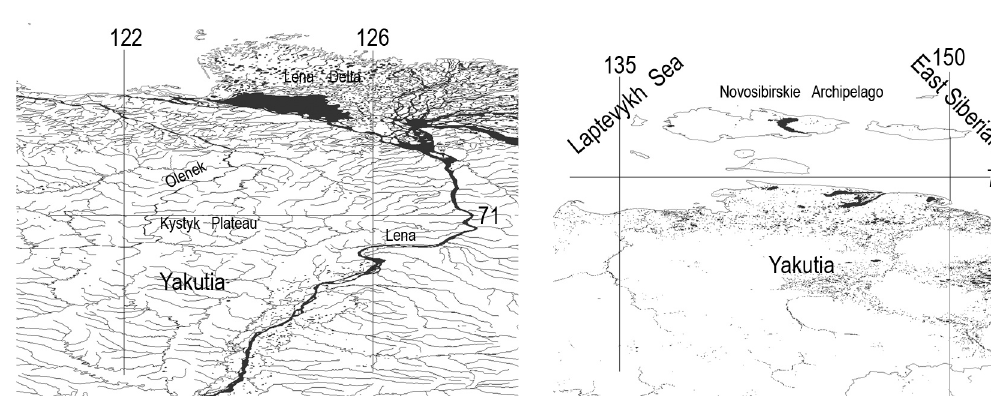
Fig. 16. Map of Kystyk Plateau calving grounds.